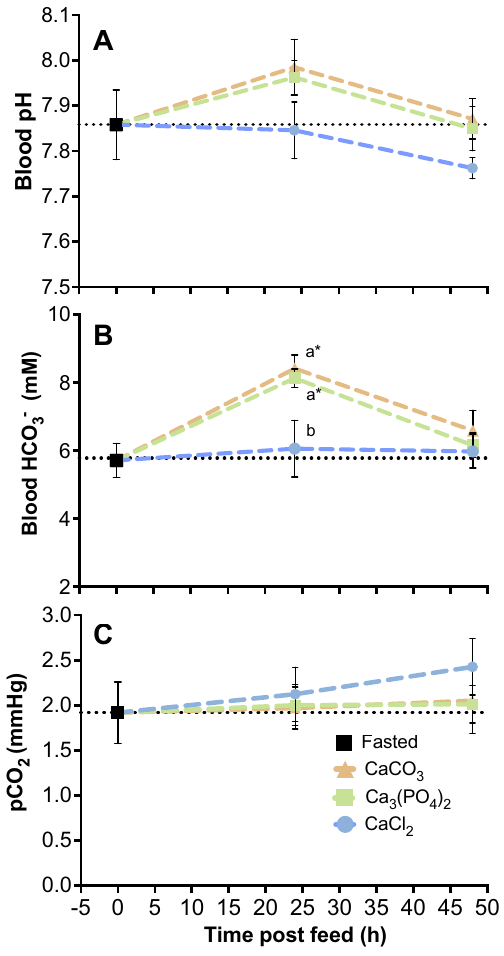
Figure 2. The average change in blood pH (A), plasma HCO 3 − concentration (B) and pCO 2 (C) over time in juvenile rainbow trout (n = 40) ( Oncorhynchus mykiss ) fed voluntarily on a 2.5% ration of one of three diets supplemented with either CaCl 2 , CaCO 3 or Ca 3 (PO 4 ) 2 . Data are expressed as means ± SE. Different letters (abc) indicate significant differences between groups at 24 or 48 h post feed following a one-way ANOVA and Tukey multiple comparisons test. Significance was accepted at P <